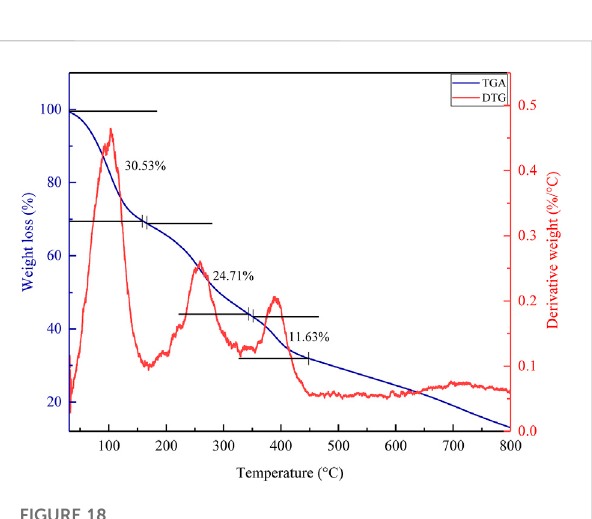
FIGURE 18 TGA analysis of grafted okra